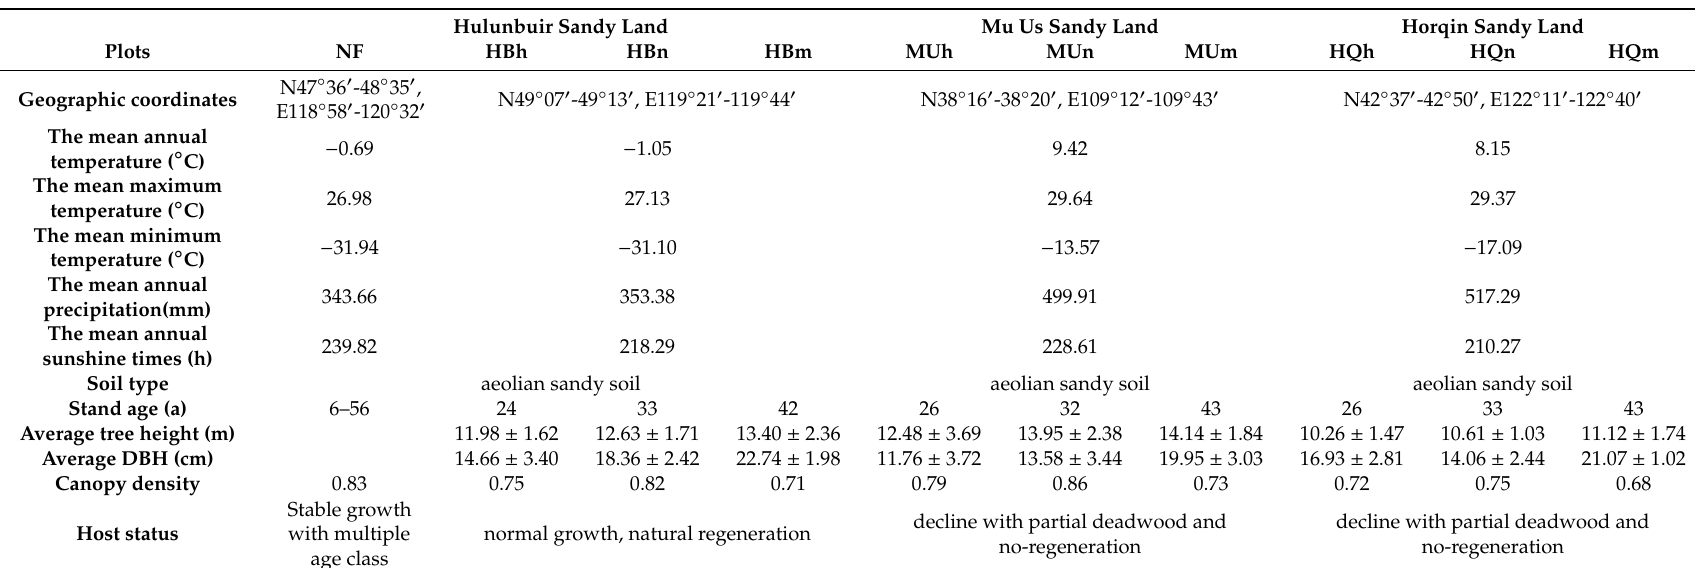
Table 1. General information of study and sampling